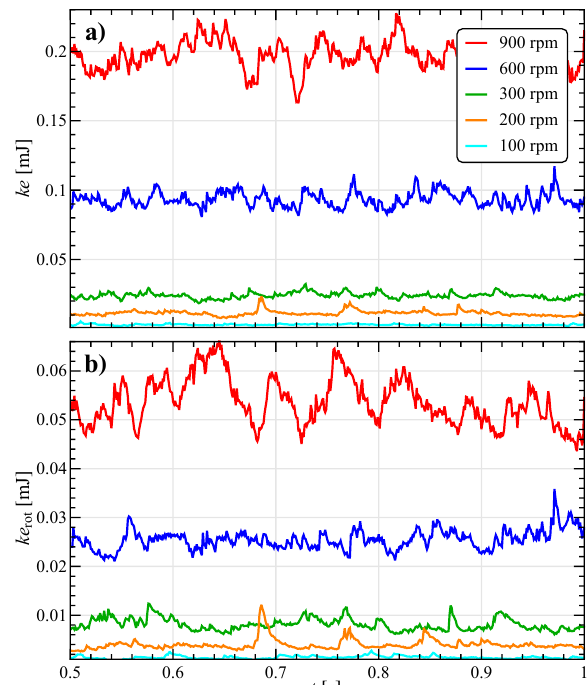
Figure 3. Total ( a ) translational and ( b ) rotational kinetic energy for the reference system at different stirring velocities in a time window of 0.5s after the initialization